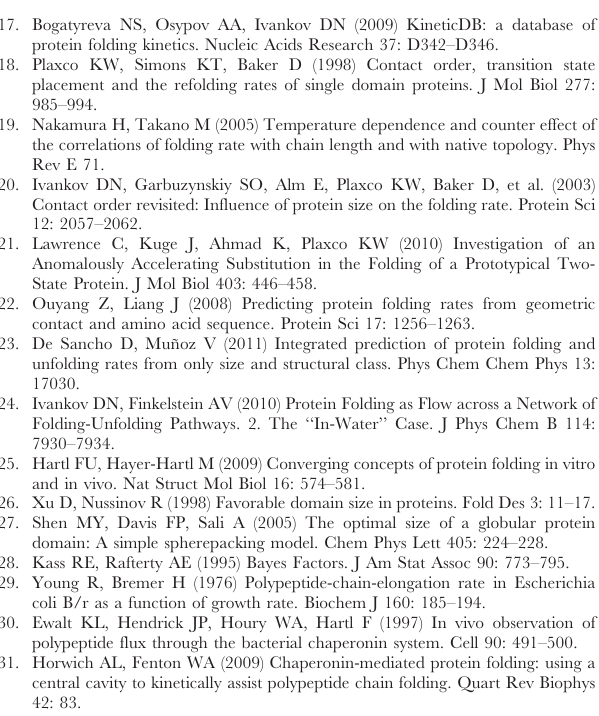
Figure S1. The rate-length data from each source used, plotted together. Even though there is some overlap in reported sequences, many identical proteins have different chain lengths or folding times reported. We combined these data for our analysis, eliminating only identical measurements. Figure S2. The parameter fit for a stretched exponential, log t ! a N b , with b a free parameter. Notice how the fit is perfectly straight on a log-log plot, a characteristic trait of power laws. Figure S3. The parameter posteriors for each model are sharply peaked around their modes. Plotted here is the maximum (not the marginal value) of the posterior at various values of the key parameters a or n . One can see that the likelihood has a sharply peaked value along this dimension. Table S1. The KineticDB dataset with mutants included. Since there are only a few proteins with mutants, and there are many mutants for these few proteins, this database gives artificially more weight to those individual proteins. Table S2. Bayes factors comparing